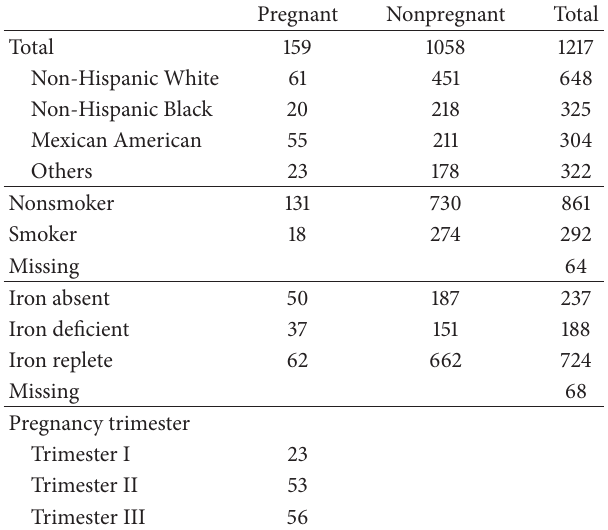
Table 1: Unweighted sample sizes by race/ethnicity, smoking status, iron storage status, pregnancy status, and pregnancy trimester.